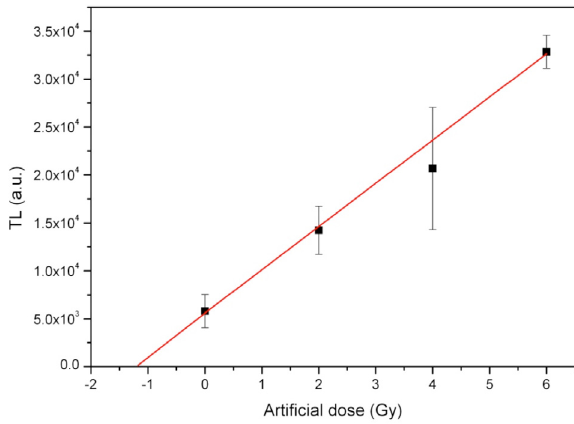
Figure 8. Linear fit for Equivalent Dose (ED) calculation for the TL 2 sample.